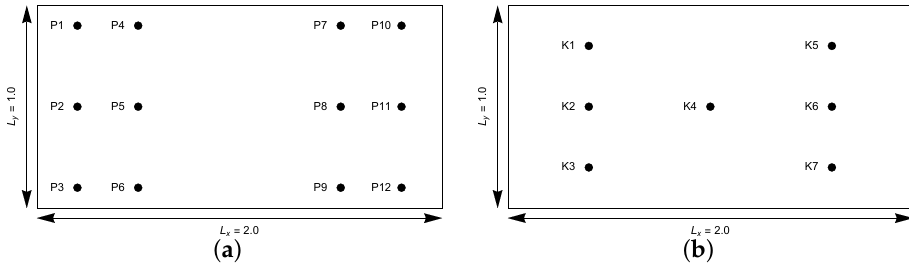
Figure 2. Two different arrangements of the measuring